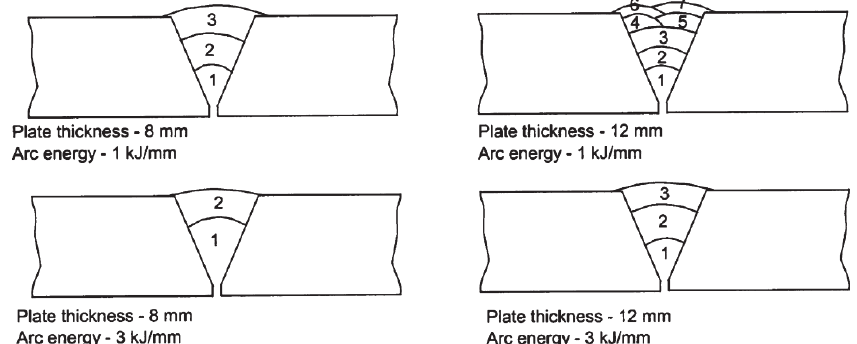
Figure 2: Different scenarios of multi-pass weld runs examined in [5].